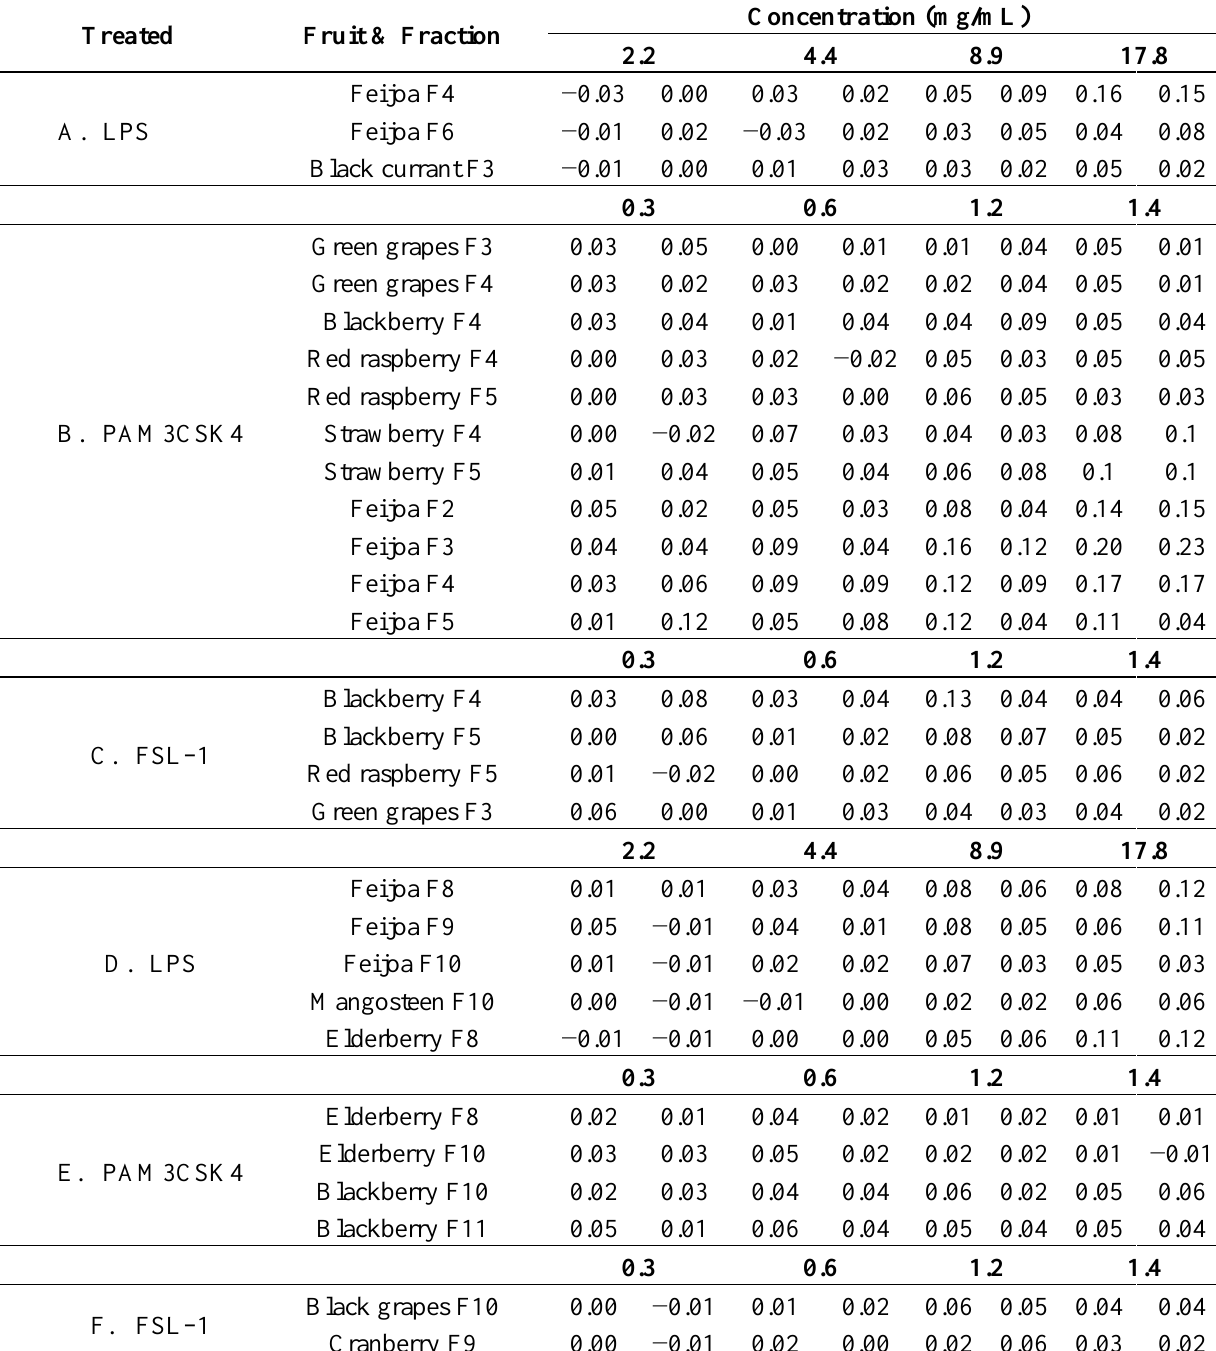
Table 2. Anti-inflammatory response mediated by hydrophilic (A–C) and hydrophobic (D–F) fractions. Concentration columns showing two replicates for each fraction.